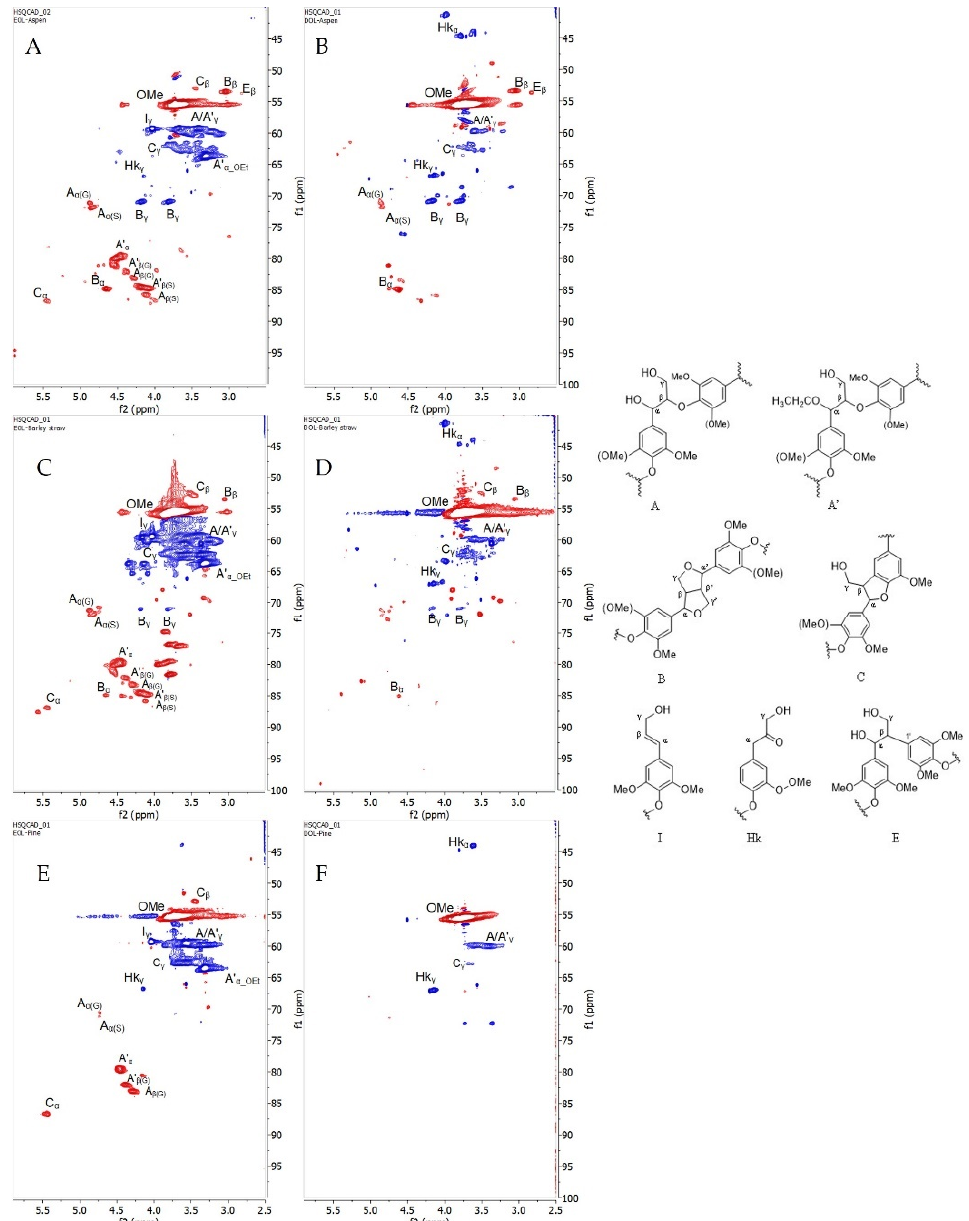
Figure 4. ( Left ) HSQC spectra that were presented in the oxygenated aliphatic side chain region from six organosolv lignins, ( A ) EOL-Aspen, ( B ) DOL-Aspen, ( C ) EOL-Barley straw, ( D ) DOL-Barley straw, ( E ) EOL-Pine, and ( F ) DOL-Pine. Red cross peaks are CH 3 and CH; blue cross peaks are CH 2 . ( Right ) ( A ) β-O-4′ alkyl-aryl ethers; ( A’ ) β-O-4′ alkyl-aryl ethers with ethoxylated α-OH; ( B ) resinols; ( C ) phenylcoumarans; ( I ) cinnamyl alcohol-end groups; ( Hk ) Hibbert’s ketone (end- group); ( E ) β-1′ linkage.